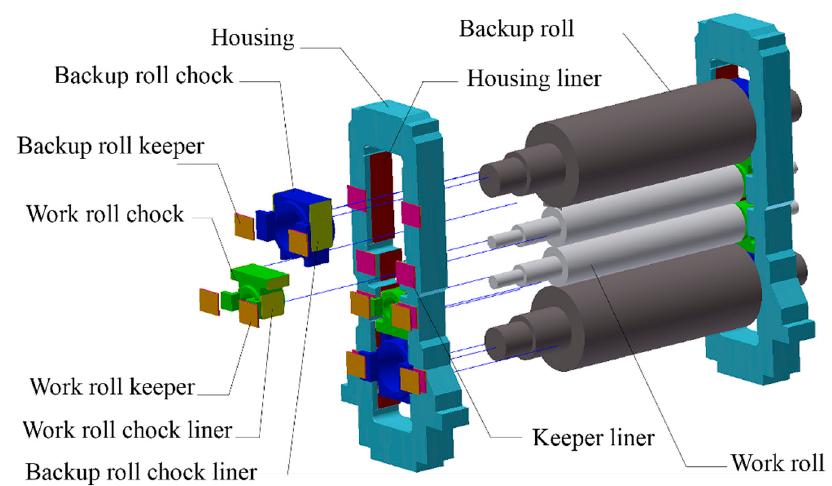
Figure 1. Viewofafinishing stand.